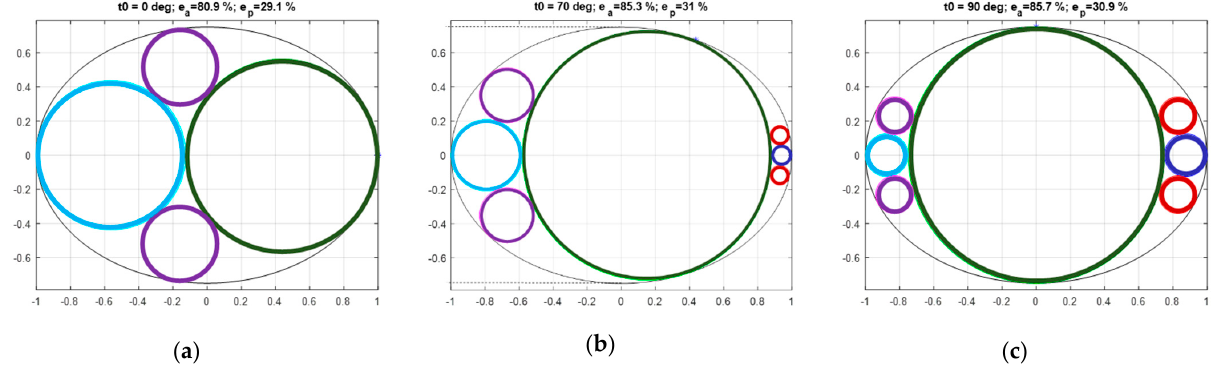
Figure 10. Examples of full-section layouts without minimum radius constraints for three different 𝑡 (cid:2868) values: ( a ) 0°, ( b ) 70°, ( c ) 90°.